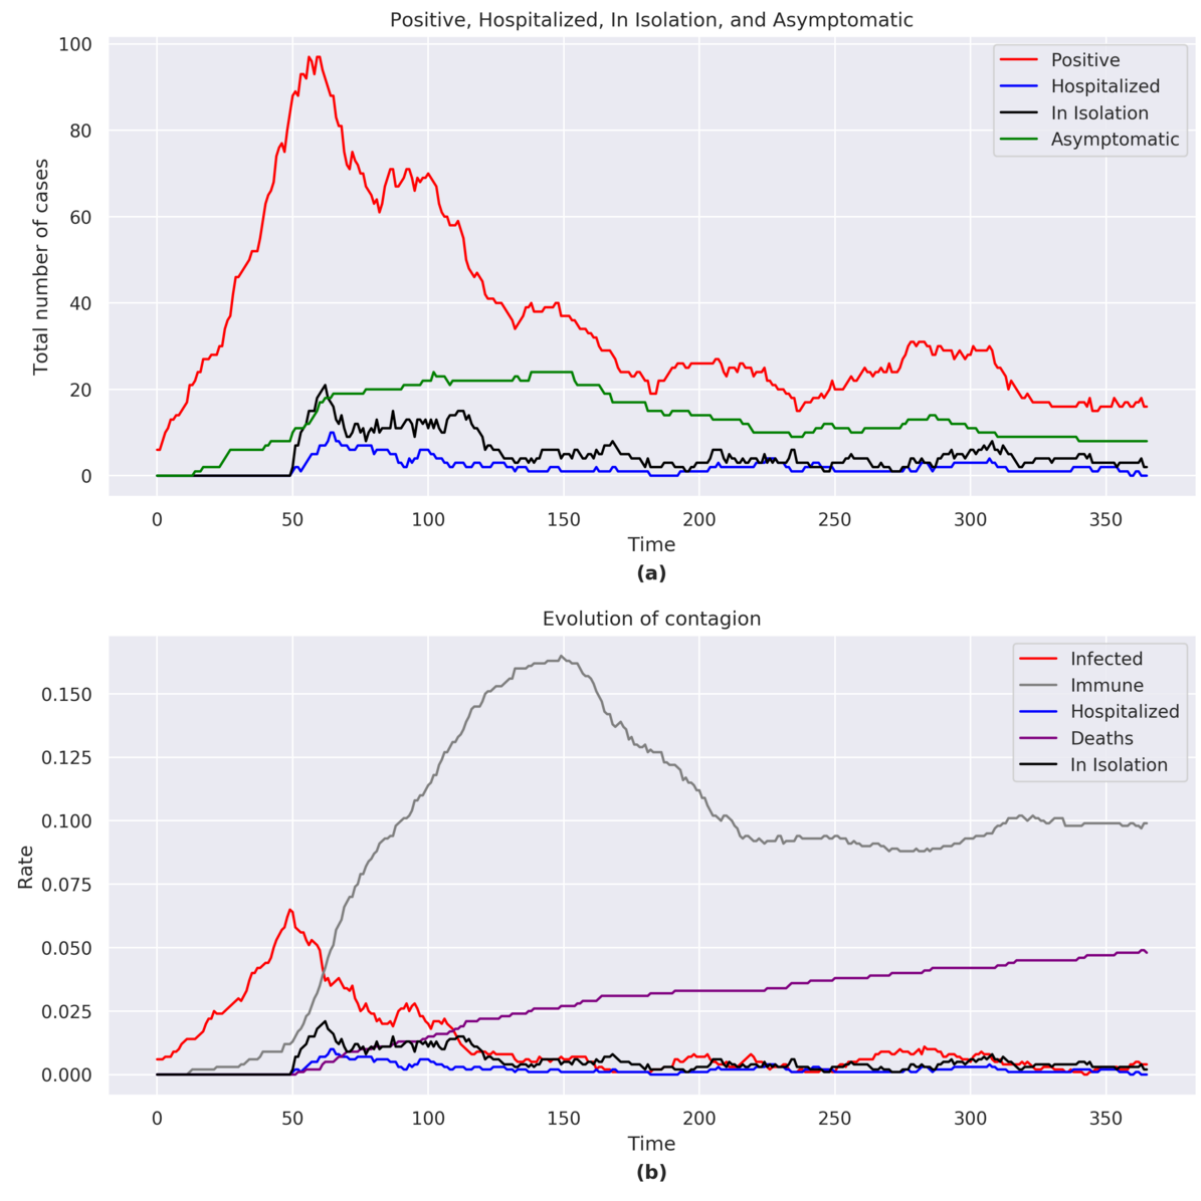
Figure 2. (a) Positive, hospitalized, in isolation, and asymptomatic figures for Italy. (b) Evolution of the contagion for Italy. The graphs consider the sum of the agents belonging to each category shown in the legend for each day of the